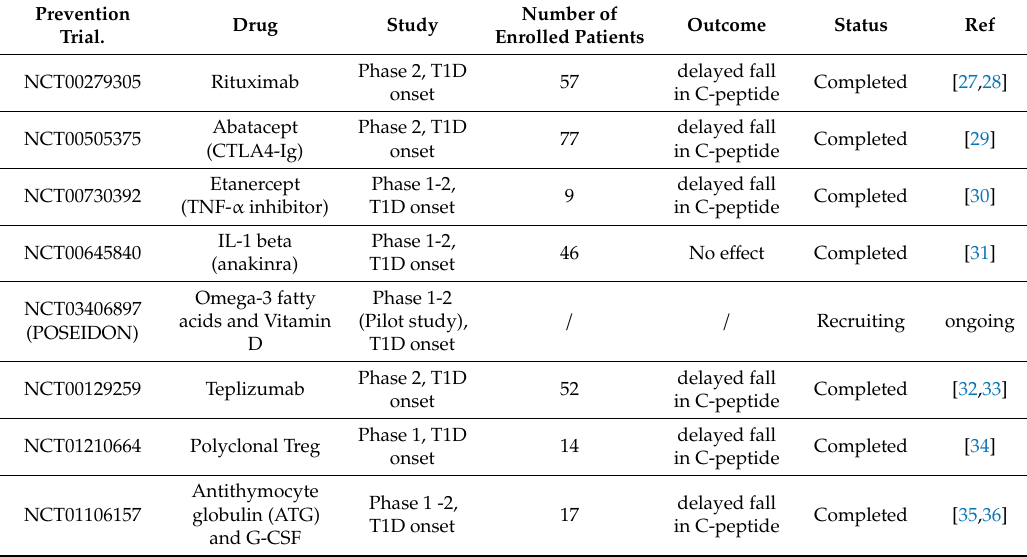
Table 2. Prevention trials at T1D